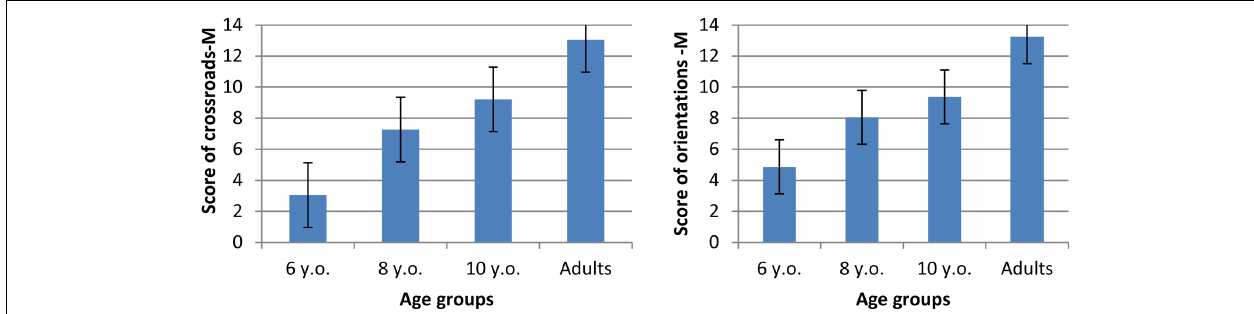
FIGURE 9 | Mean scores for crossroads-M and orientations-M indicated on the